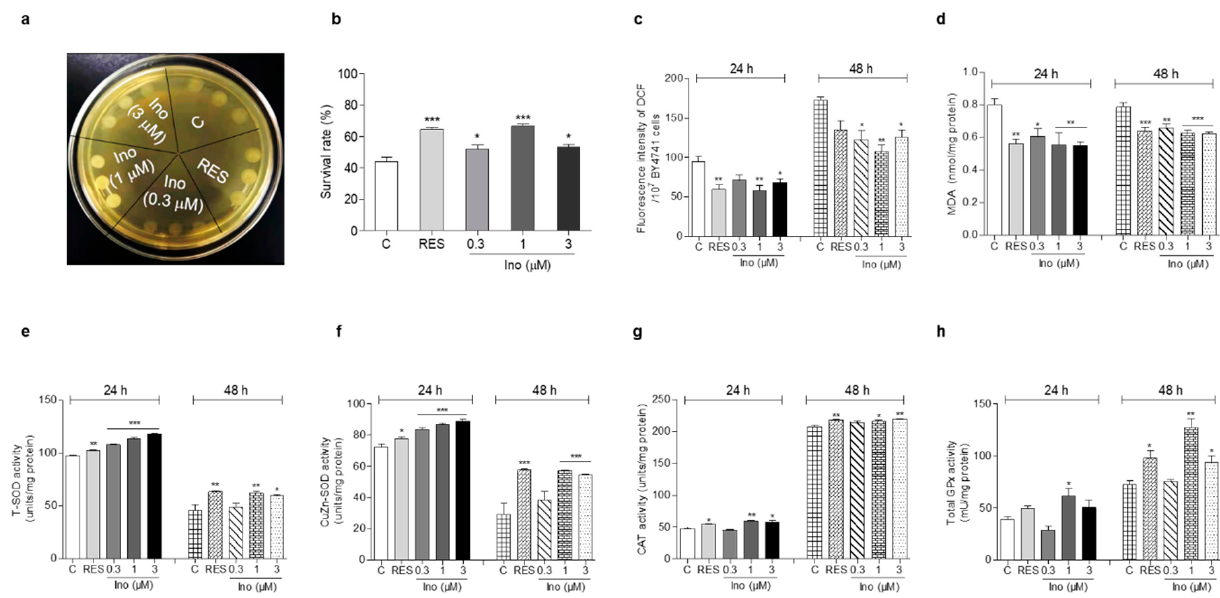
Figure 2. Effect of inokosterone on oxidant stress and antioxidant enzyme activity. ( a ) The growing status of BY4741 upon inokosterone treatment under H 2 O 2 stimulation at 10 mM. ( b ) The survival rate of BY4741 after inokosterone treatment under H 2 O 2 stimulation at 6.8 mM. ( c , d ) The effect of inokosterone on ROS and MDA levels at 24 and 48 h. ( e – h ) The changes of the T-SOD, SOD1, CAT, and GPx enzyme activities in yeast after the treatment of inokosterone for 24 and 48 h. The experiments were repeated thrice, and the data are presented as the mean ± SEM. *, **, and *** indicate significant differences from the control group at p < 0.05, p < 0.01, and p < 0.001, respectively.